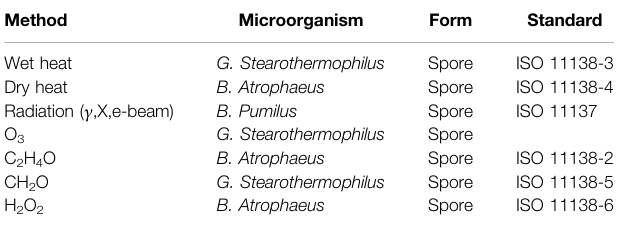
TABLE 1 | Standard sterilization methods and microorganisms commonly used as bio-indicators for these methods, modi fi ed from [6]. Method